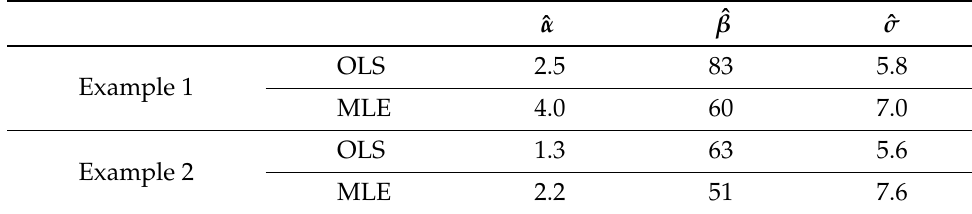
Figure 3. Fitting the path loss model to the training data with OLS (green) and MLE (red)—Example 1 ( α = 4, β = 60, σ = 7) and Example 2 ( α = 2.2, β = 51). Training data with PL under the noise threshold are shown with black dots, solid lines show PL ( d ) , and the dash lines are PL ( d ) ± 1.96ˆ σ . Table 1. Fitted ordinary least squares (OLS) and maximum likelihood estimation (MLE) parameter estimates for Example 1 ( α = 4, β = 60, σ = 7) and Example 2 ( α = 2.2, β = 51, σ =